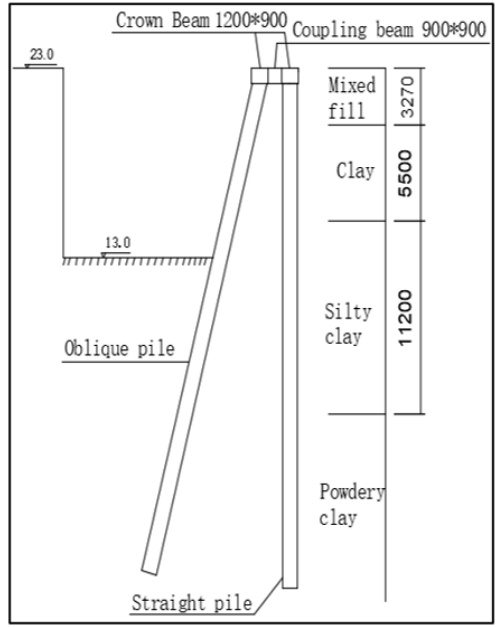
Figure 3. Layout of Foundation pit section. (unit: mm).